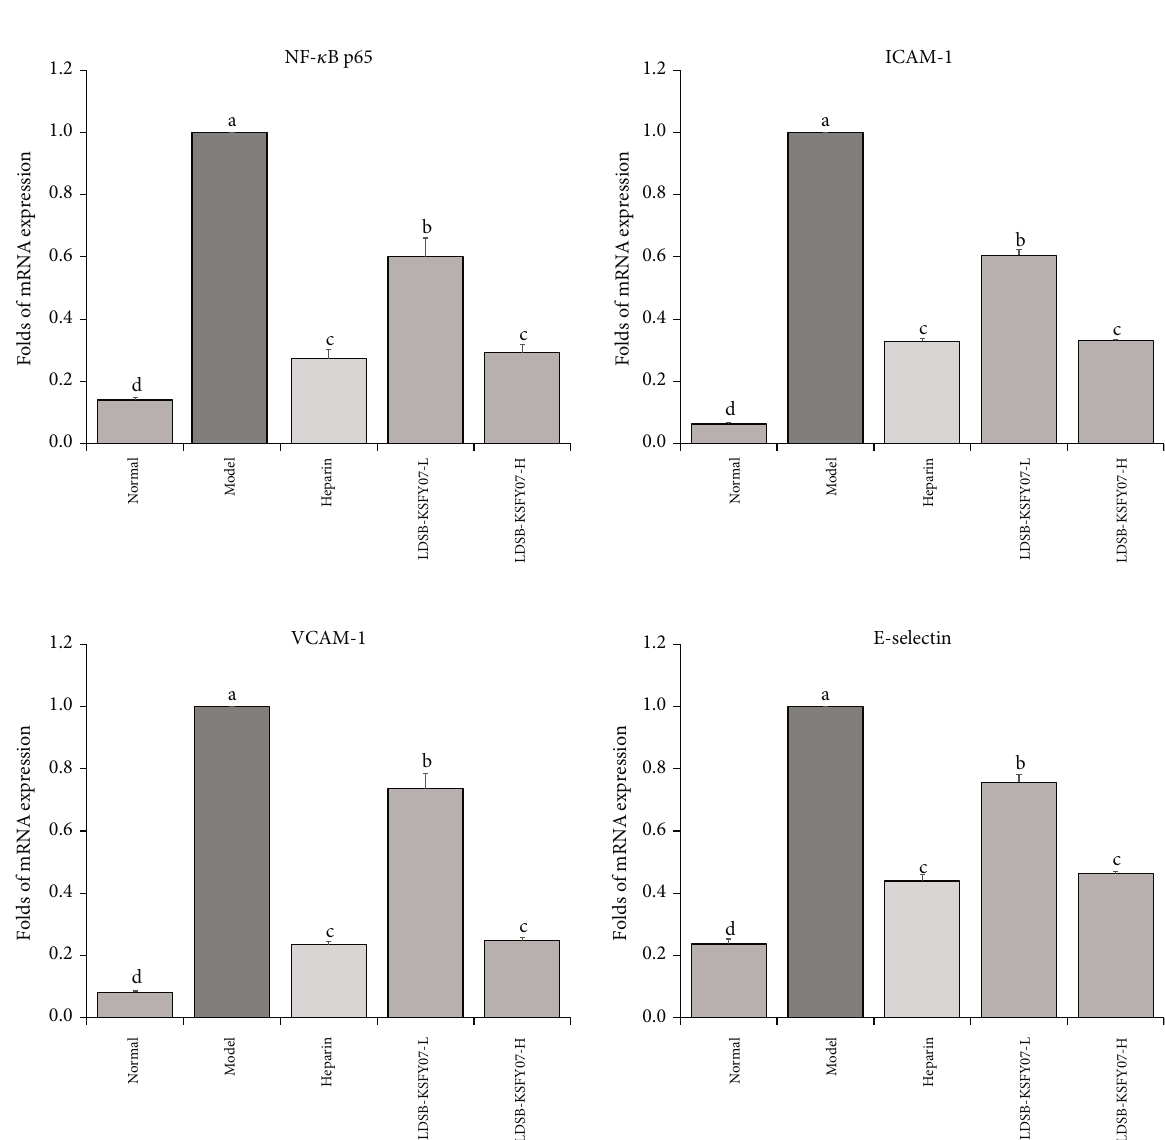
Figure 4: NF- κ B p65, ICAM-1, VCAM-1, and E-selectin mRNA expressions in tail vein tissue of mice with kappa-carrageenan-induced thrombosis. The results have been expressed as mean ± deviation . (A – D) Mean values with di ff erent bars in the di ff erent column are signi fi cantly di ff erent ( P < 0 : 05 ) according to Duncan ’ s multiple range